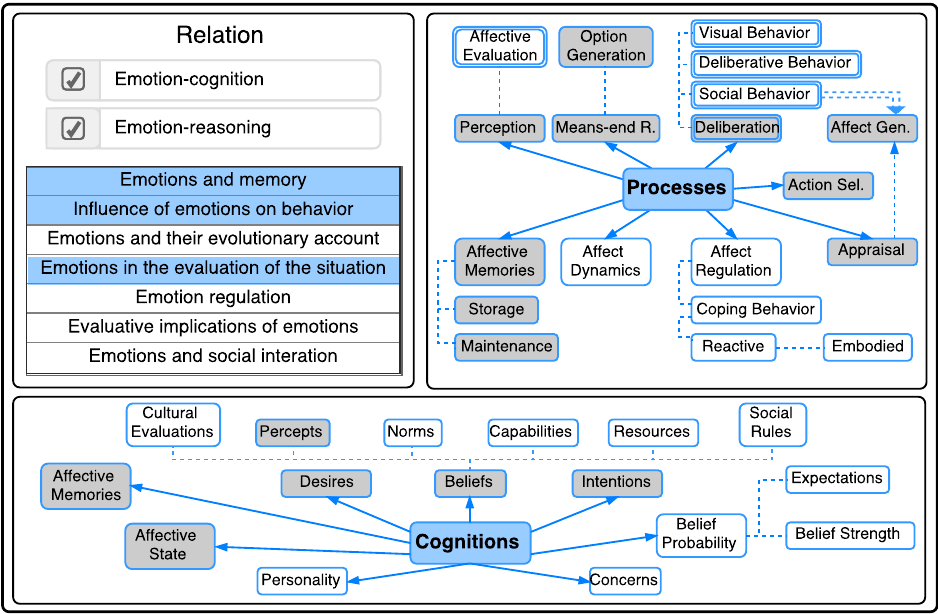
Figure 3. Processes and cognitions of the LIDA